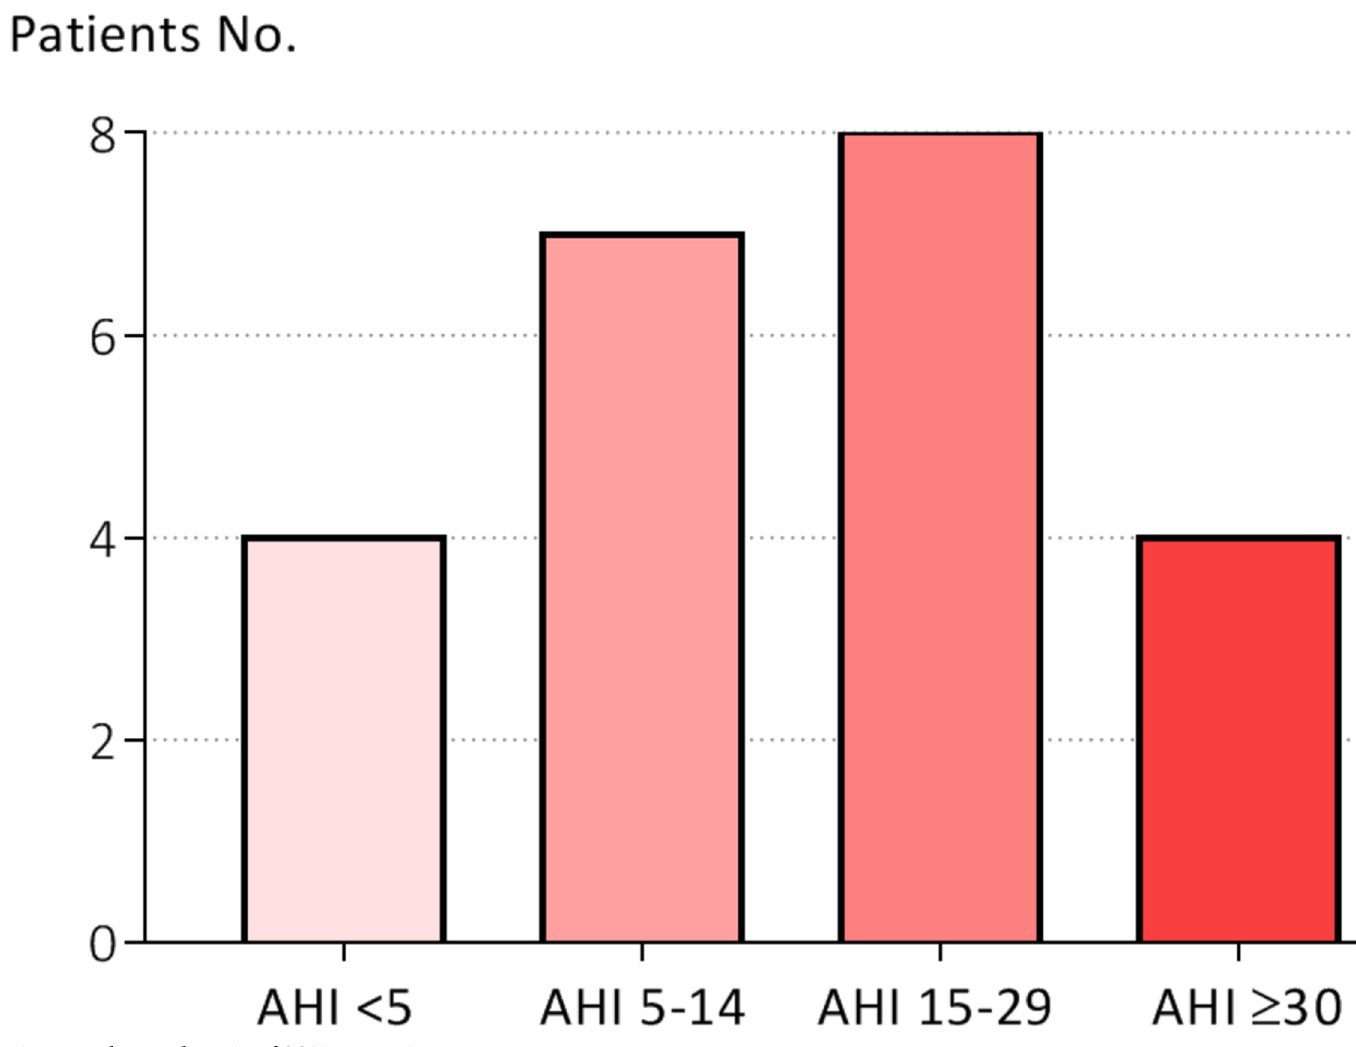
Fig 2. Prevalence and severity of OSA in IPF